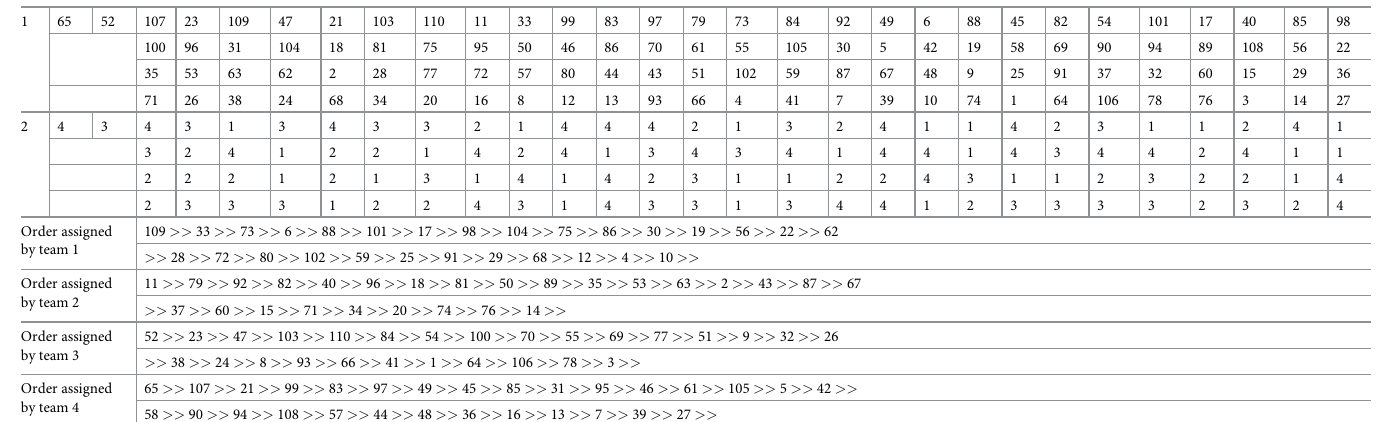
Table 5. Two chromosomes of solution (T = 33.20, σ = 15.8) in order with 110 workpieces.